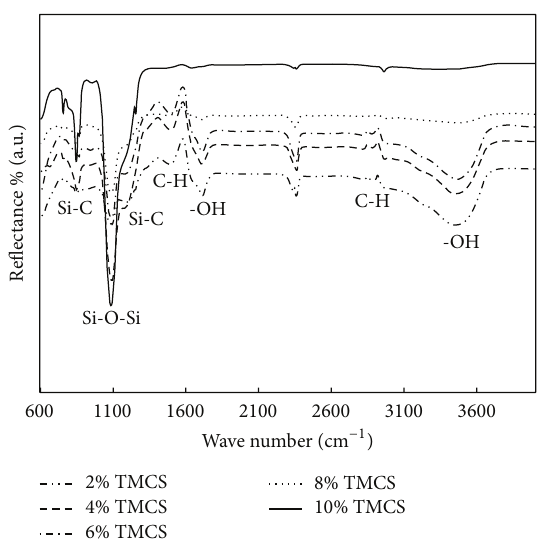
Figure 4: FTIR spectra of the aerogel